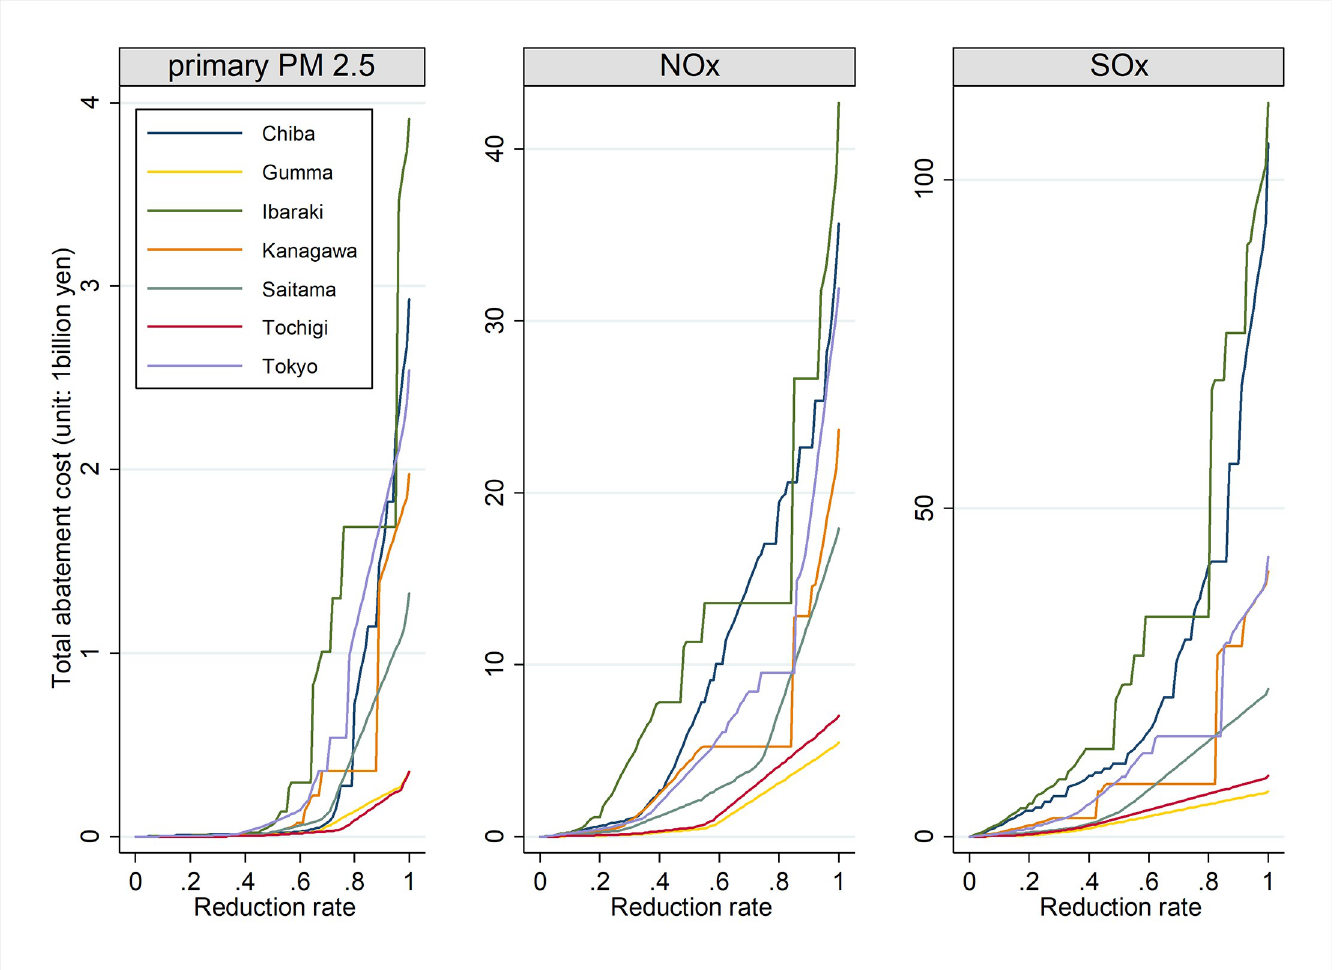
Fig 2. Relationship between total abatement costs and reduction rates by pollutant and by